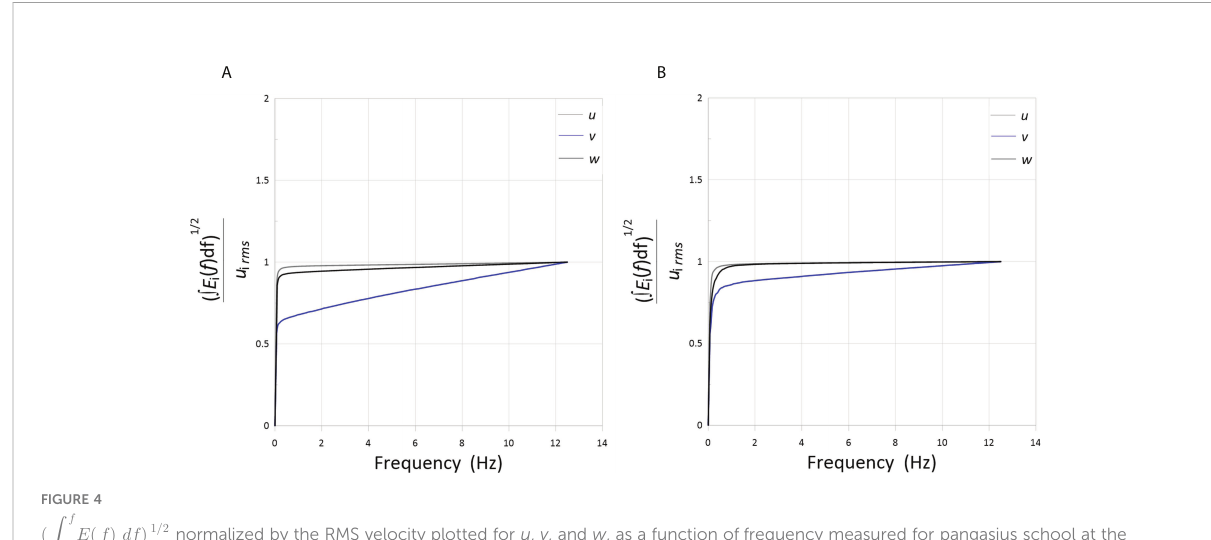
Z f ð E ð f Þ df Þ 1 = 2 normalized by the RMS velocity plotted for u , v , and w , as a function of frequency measured for pangasius school at the 0 abundance of (A) 50 and (B) 150 animal/m 3 .